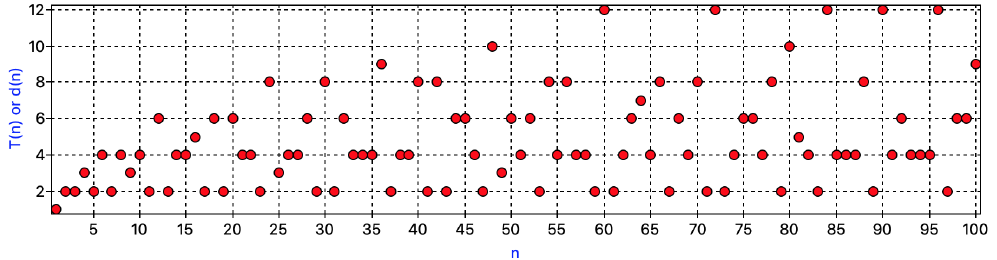
Figure 11. The simulation for τ ( n ) with 1 ≤ n ≤